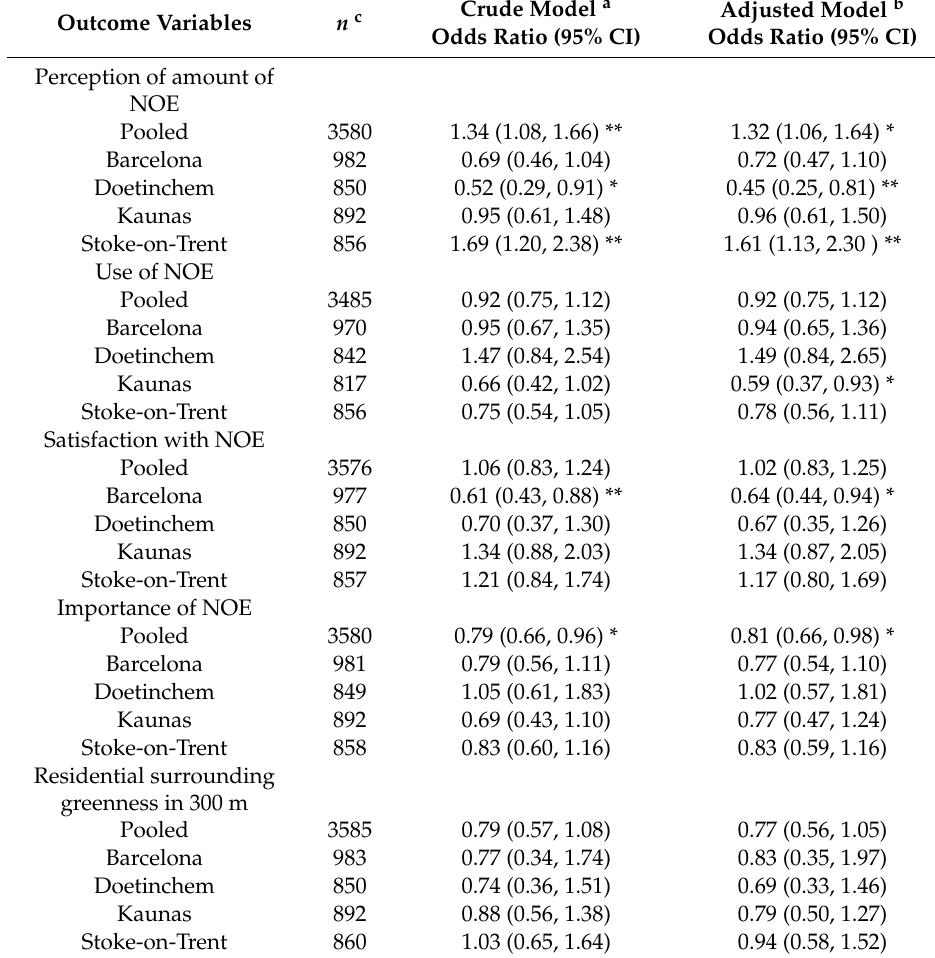
Table 8. Mixed e ff ects regression of childhood NOE exposure (low levels vs. high levels) on the amount of NOE, use of NOE, satisfaction with NOE, importance of NOE, and residential surrounding greenness in 300 m. Pooled and city-specific